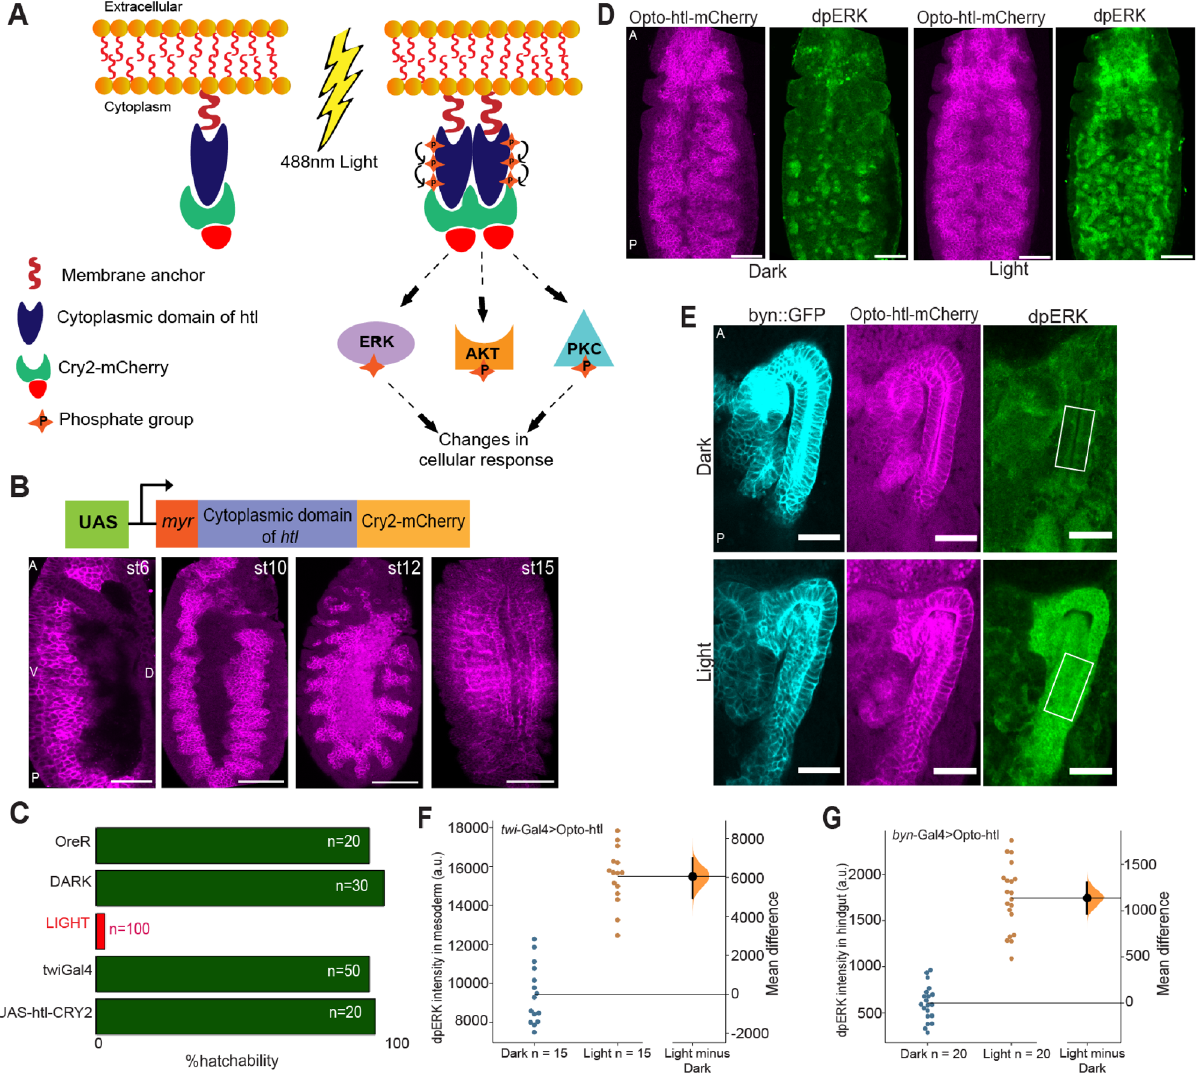
Figure 1. Opto-htl expression and activation in different tissues. ( A ) Schematic showing design and activation of Opto-htl. Exposure to 488 nm light induces CRY2 clustering leading to activation of the (intracellular) membrane-bound receptor and eventually generating a cellular response via phosphorylation of various downstream target molecules. ( B ) twi ::Gal4 > Opto-htl embryos stained with anti-mCherry antibody showing the expression of the construct at various stages. ( C ) Hatching rate assay for different genetic conditions. OreR = OregonR embryos under illumination, DARK = twi ::Gal4 > Opto-htl embryos kept under illumination with amber paper to block 488 nm wavelengths throughout development, LIGHT = twi ::Gal4 > Opto-htl embryos kept under illumination throughout development. twi ::Gal4 embryos represent the Gal4 driver alone and UAS-htl-Cry2-mCherry represents Opto-htl embryos with no Gal4 driver kept under similar illumination conditions. ( D ) twi ::Gal4 > Opto-htl embryos fixed and stained at late stage 10/early stage 11 for dpErk under dark and light conditions. ( E ) Byn ::Gal4 > Opto-htl embryos fixed and stained at stage 16 for dpErk under dark and light conditions (scale bar 25 mm). ( F ) dpErk intensity differences in the mesoderm at late stage 10 between twi ::Gal4 > Opto-htl embryos kept under dark versus light. ( G ) dpErk intensity differences in the hindgut between Byn ::Gal4 > Opto-htl embryos under dark and light conditions in stage 16 measured in the region shown in ( E ). Scale bar = 50 μm unless stated otherwise. A = Anterior, P = Posterior, D = Dorsal, V = Ventral view. In ( F , G ), the black bar represents the 95% confidence interval with the Bootstrap distribution shown in orange and n represents number of embryos for each condition 68